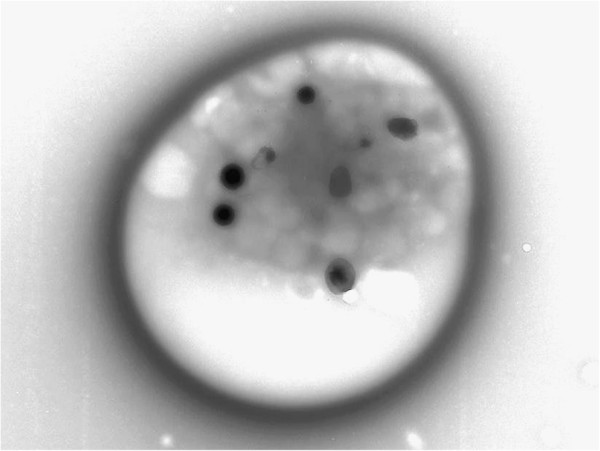
Transmission electron micrographic image of a normal platelet with 8 dense (δ) granules evident (whole mount EM, unstained; 10,000X).